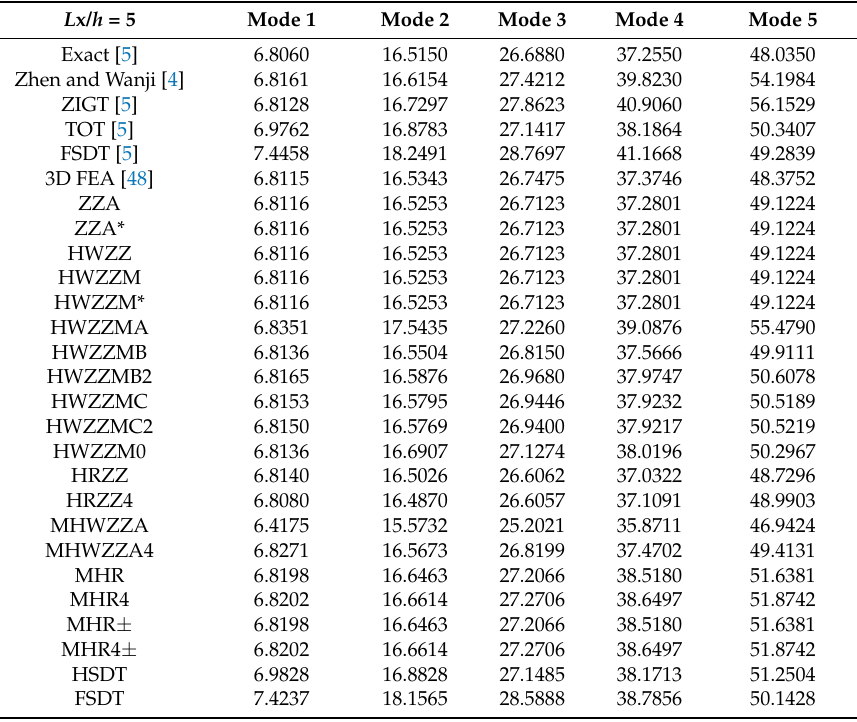
Table 12. Normalized fundamental frequencies, case